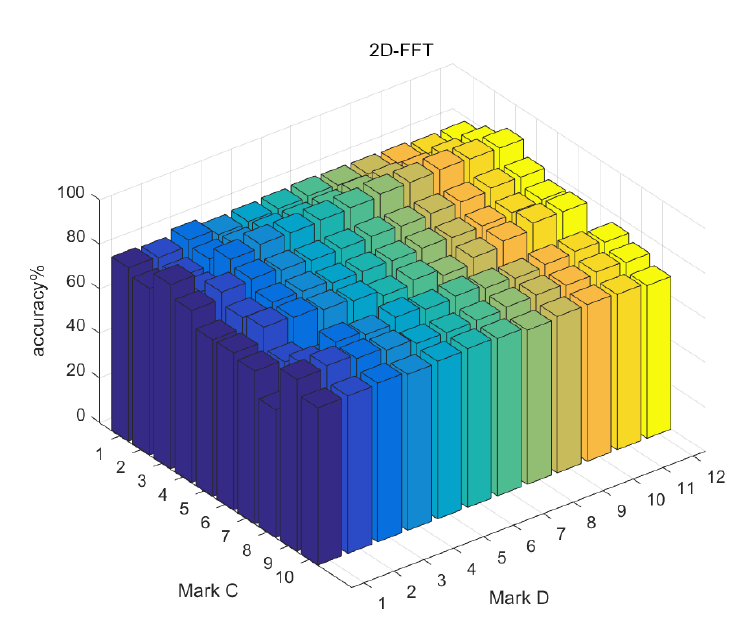
Figure 13. Evaluation of HOVI.